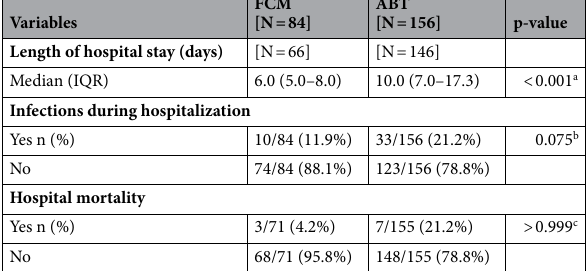
Table 5. Comparative analysis between FCM and ABT group concerning the length of hospital stay, infections during hospitalization and hospital mortality. a Mann–Whitney-Wilcoxon test applied; b Chi-square test applied; c Fisher’s exact test